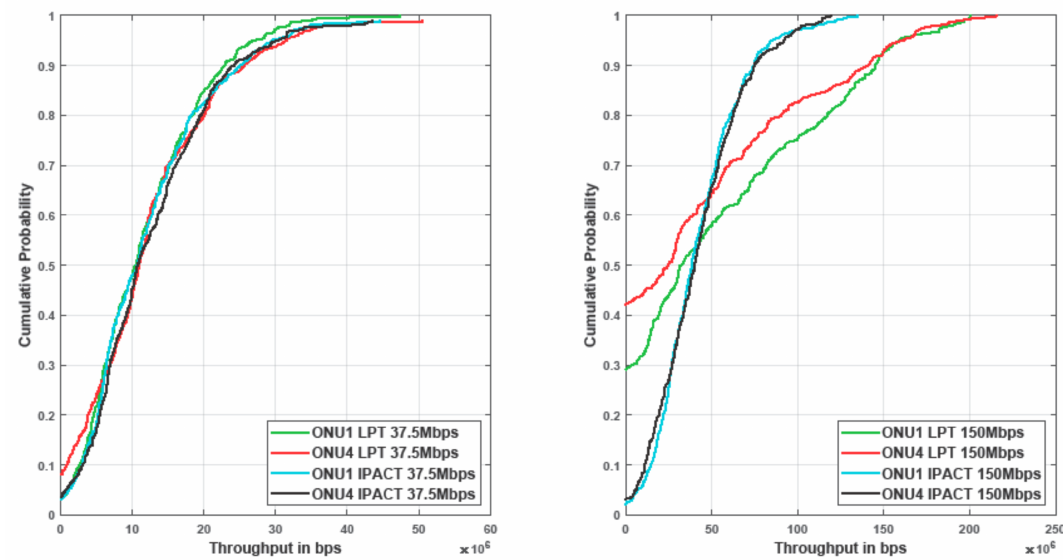
Figure 6. CDF of the throughput for ONU 1 and 4 at LTT = 0 µ s; IPACT vs. LPT at low load ( left ) and heavy load ( right